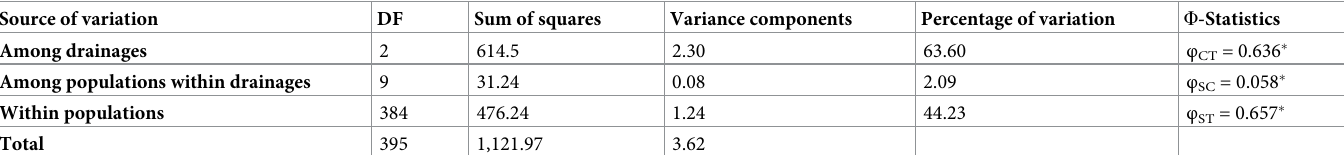
Table 6. Results of hierarchical analyses of molecular variation (AMOVA) for the SNP dataset from 12 populations of A . barbouri in Tennessee. Assignment to mitochondrial clades are as follows: Clade II (S5, S7, and S8), Clade IV (D3, W1, W3, and W4), and Clade III (Wil2, R1, R7, R9, B6). Asterisks indicate significance of F sta- tistics based on 1000 permutations in